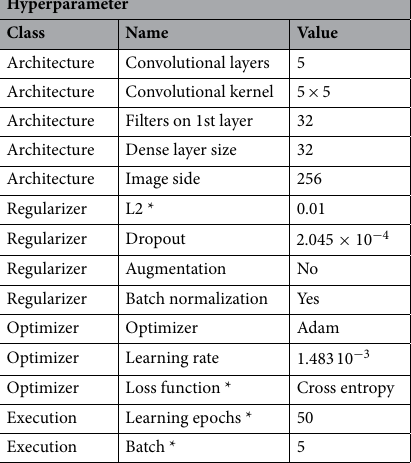
Table 2. Best hyperparameters after tuning. *Only one value was tested for this